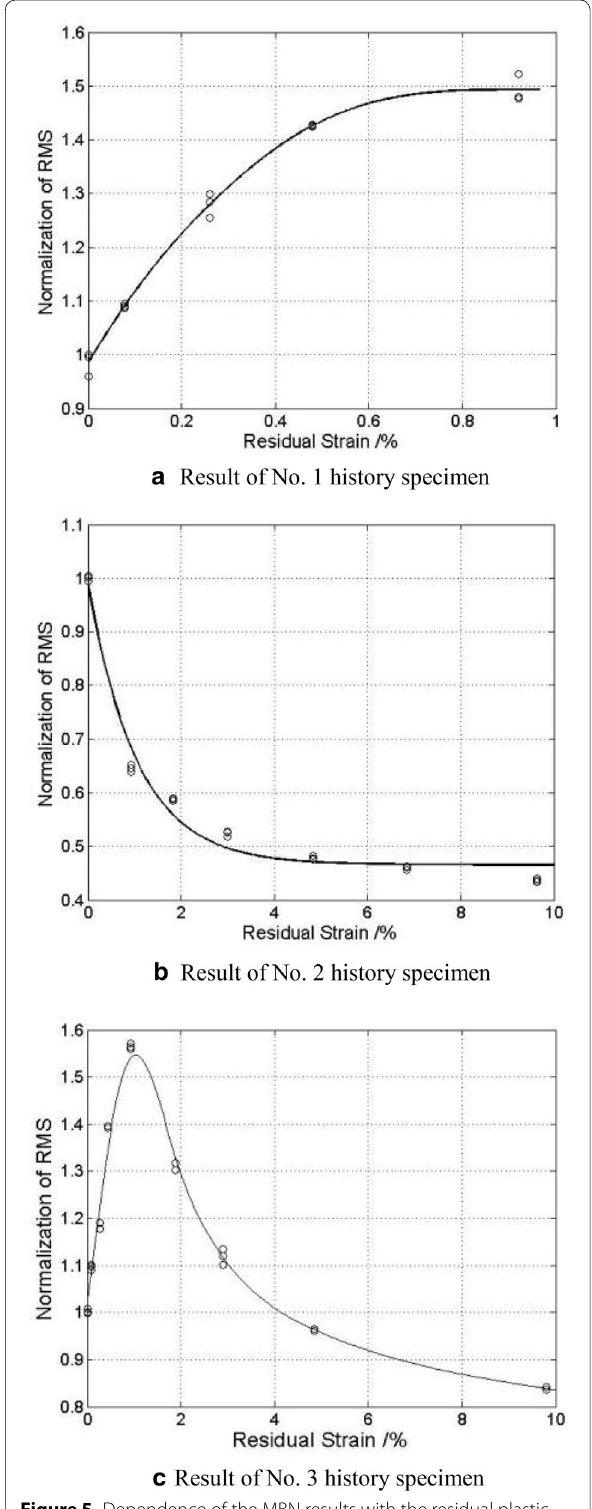
Figure 5 Dependence of the MBN results with the residual plastic strain for history